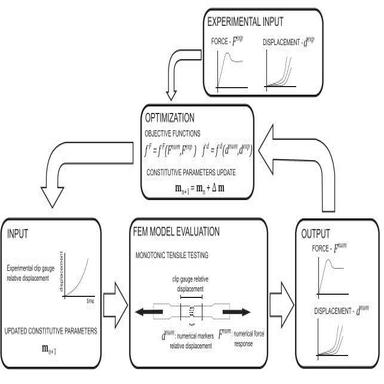
FEMU schematic representation.